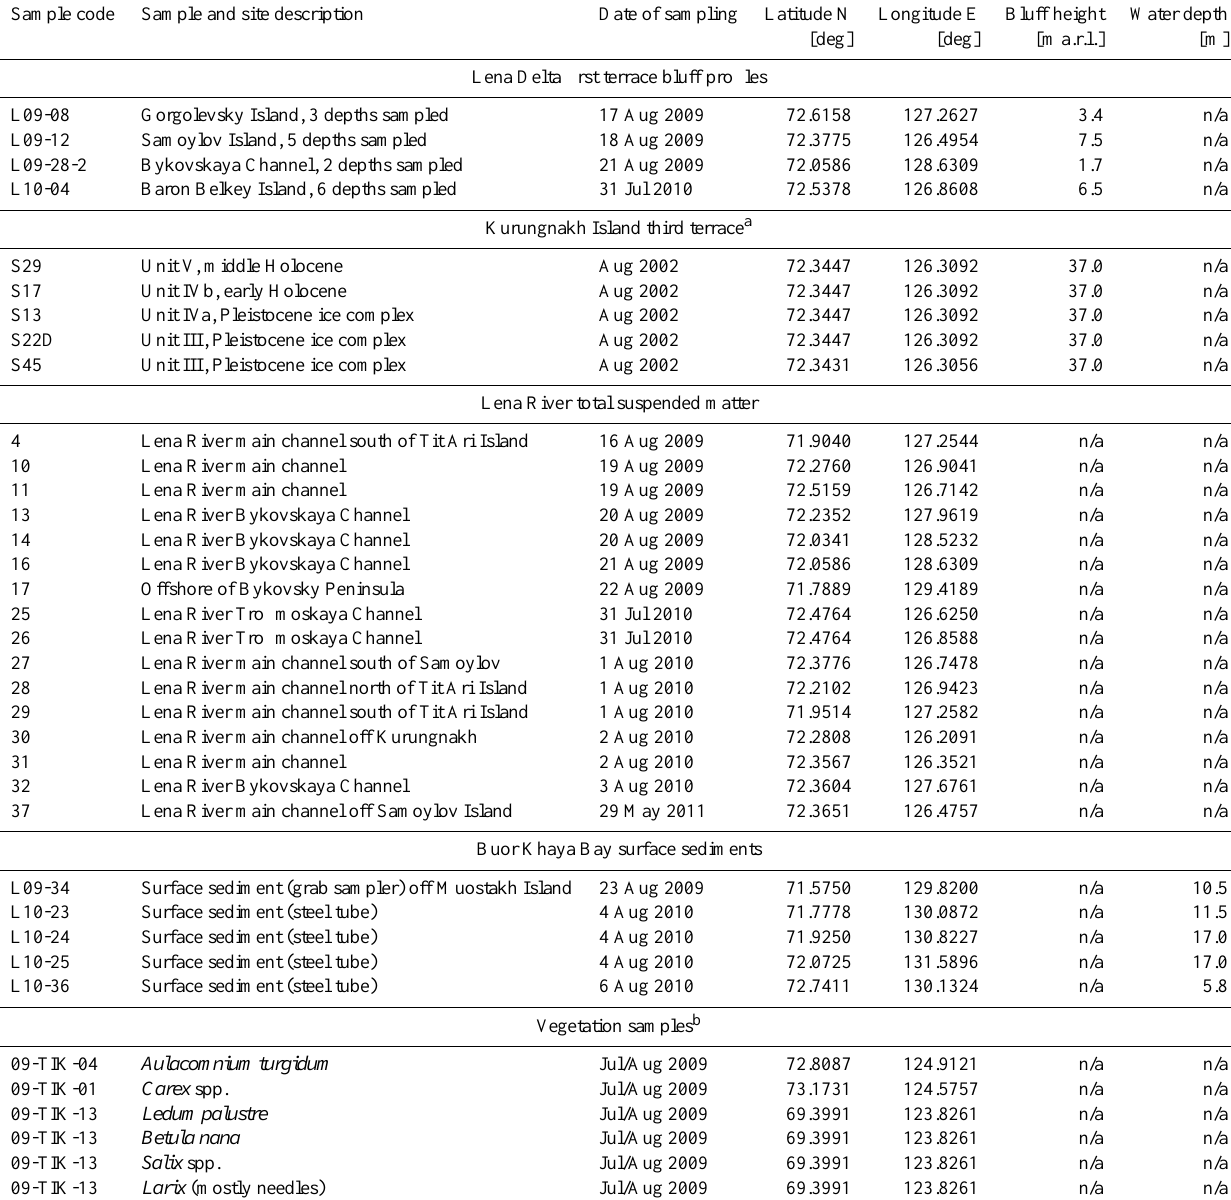
Table 1. Samples presented in this study and analyzed for lignin phenol composition. Bluff height is given in meters above river level [ma.r.l.] measured in August 2009 and July/August 2010. All total suspended matter samples from 2009 to 2011 were taken from the surface water layer with a sampling depth of ca. 0.5m. Additional surface water samples used for total suspended matter determination can be found in Table S1 in the Supplement. Not applicable denoted by